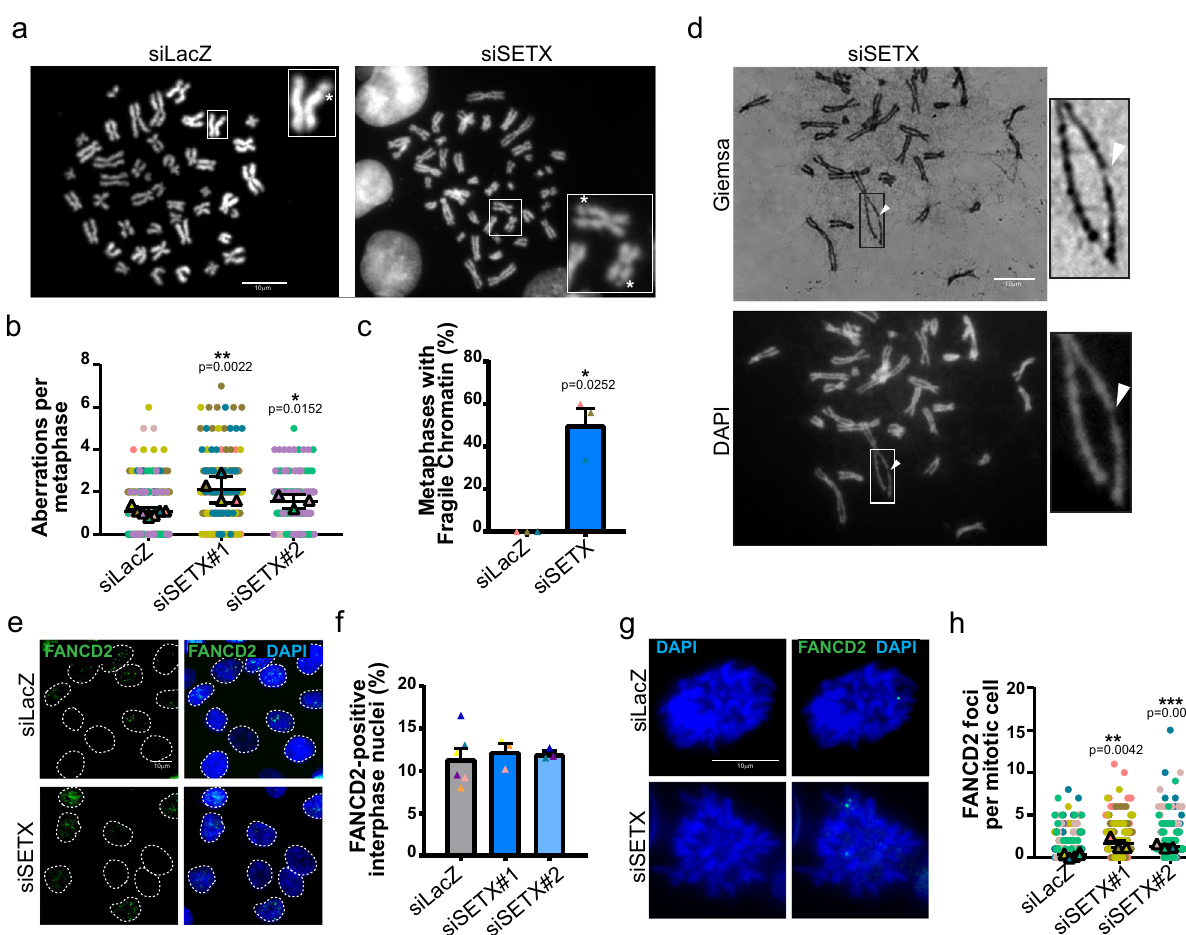
Fig. 1 SETX depletion triggers chromosome fragility and recruitment of FANCD2 in mitotic cells. a Representative images of metaphases from control (LacZ) and SETX siRNA-transfected cells. Chromosomes exhibiting gaps are magni fi ed in insets. b Quanti fi cation of chromosome aberrations (gaps or under-condensed regions) on mitotic chromosomes from control, siSETX#1 and siSETX#2 siRNA-transfected cells. c Quanti fi cation of metaphases showing fragile chromatin in control and SETX siRNA-transfected cells. d Representative metaphase from the SETX-de fi cient condition stained with Giemsa (upper panel) and DAPI (lower panel) showing the fragile chromatin phenotype characterized by unfolded chromatin at the level of weakly DAPI- stained chromatid arm. e Representative example of immuno fl uorescence analysis of FANCD2 foci in interphase nuclei from control or SETX-depleted cells. f Quanti fi cation of the percentage of FANCD2 positive (>5 FANCD2 foci) interphase cells. g Representative example of immuno fl uorescence analysis of FANCD2 foci in mitotic cells from control or SETX-depleted condition. h Quanti fi cation of the number of FANCD2 foci in mitotic